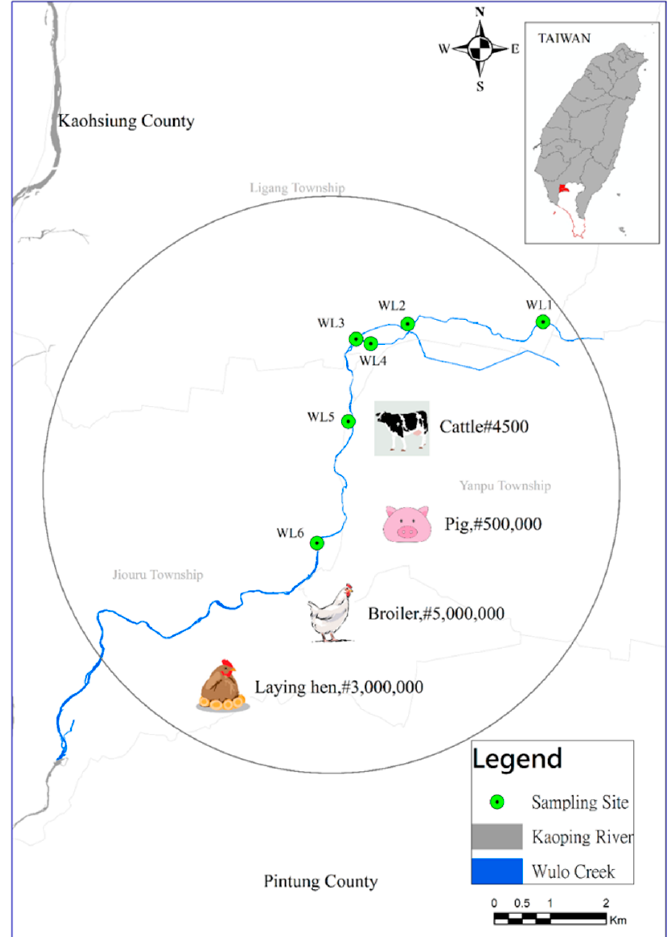
Figure 1. Sampling locations of Wulo Creek.